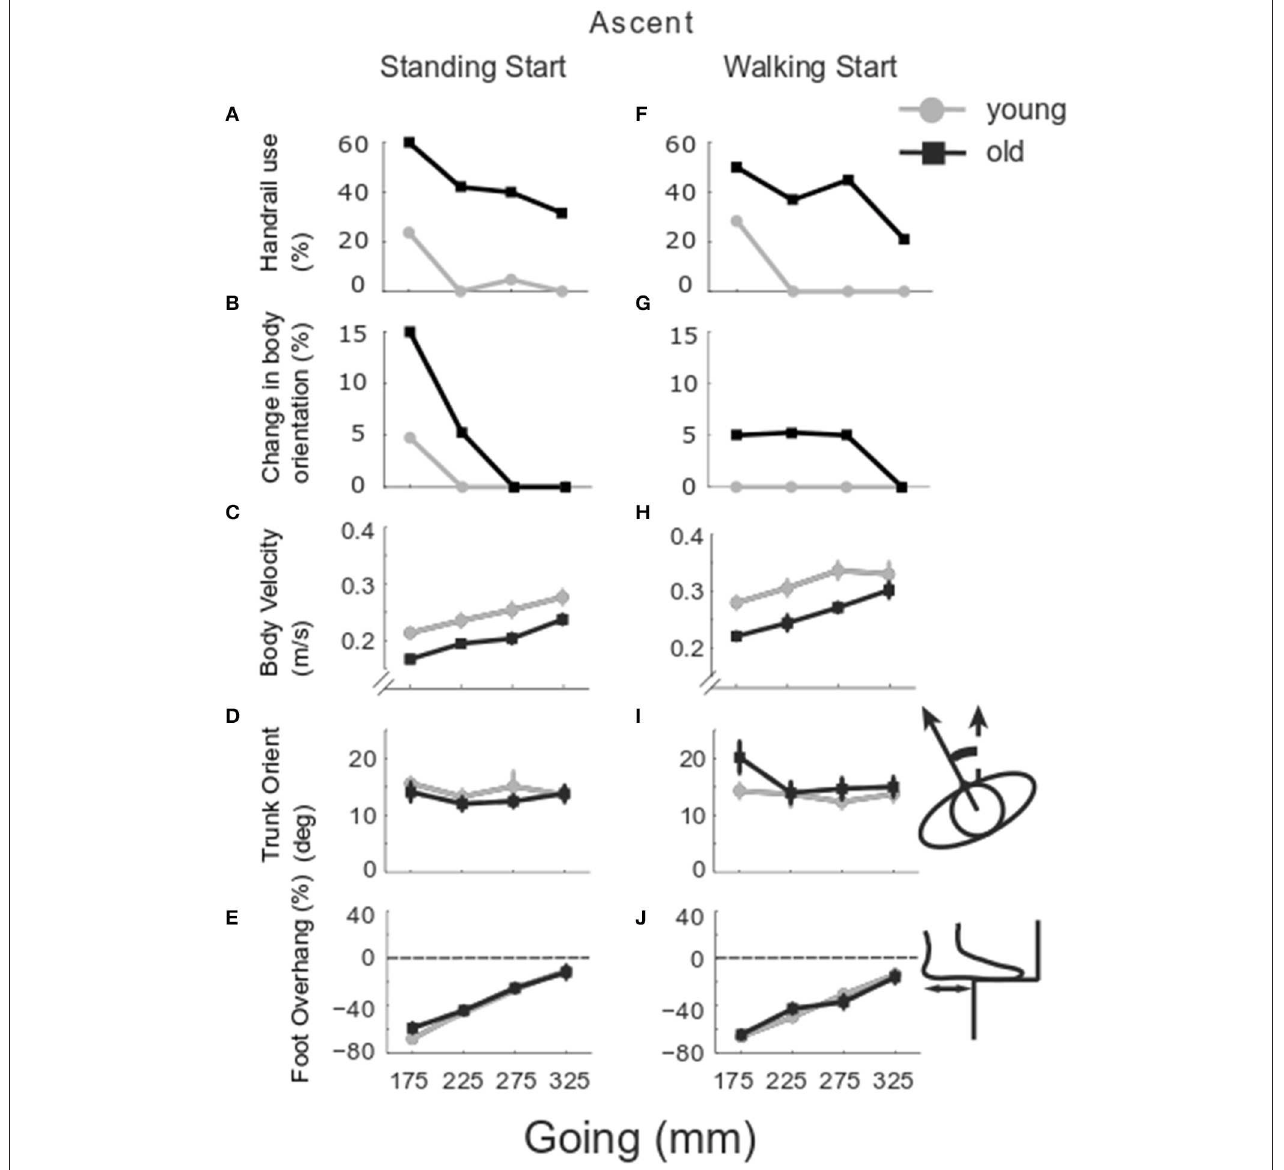
FIGURE 2 | Group stair performance in ascent. The percentage of trials in which the handrail was used (A,F) and the whole body turned toward one handrail are reported (B,G) for older (black) and younger group (gray). The group mean and SE of body velocity (C,H) , trunk orientation (D,I) and foot overhang relative to foot length (E,J) are reported for the goings investigated − 175, 225, 275, and 325mm from standing (left column) and walking start (right column). Trunk orientation was calculated relative to the trunk position whilst standing at the beginning of the recording and used as the baseline (0deg here). Foot overhang is reported as % of antero-posterior foot length, 0% means that the whole foot is placed on the step, negative values show the percentage of foot outside the step at foot landing.